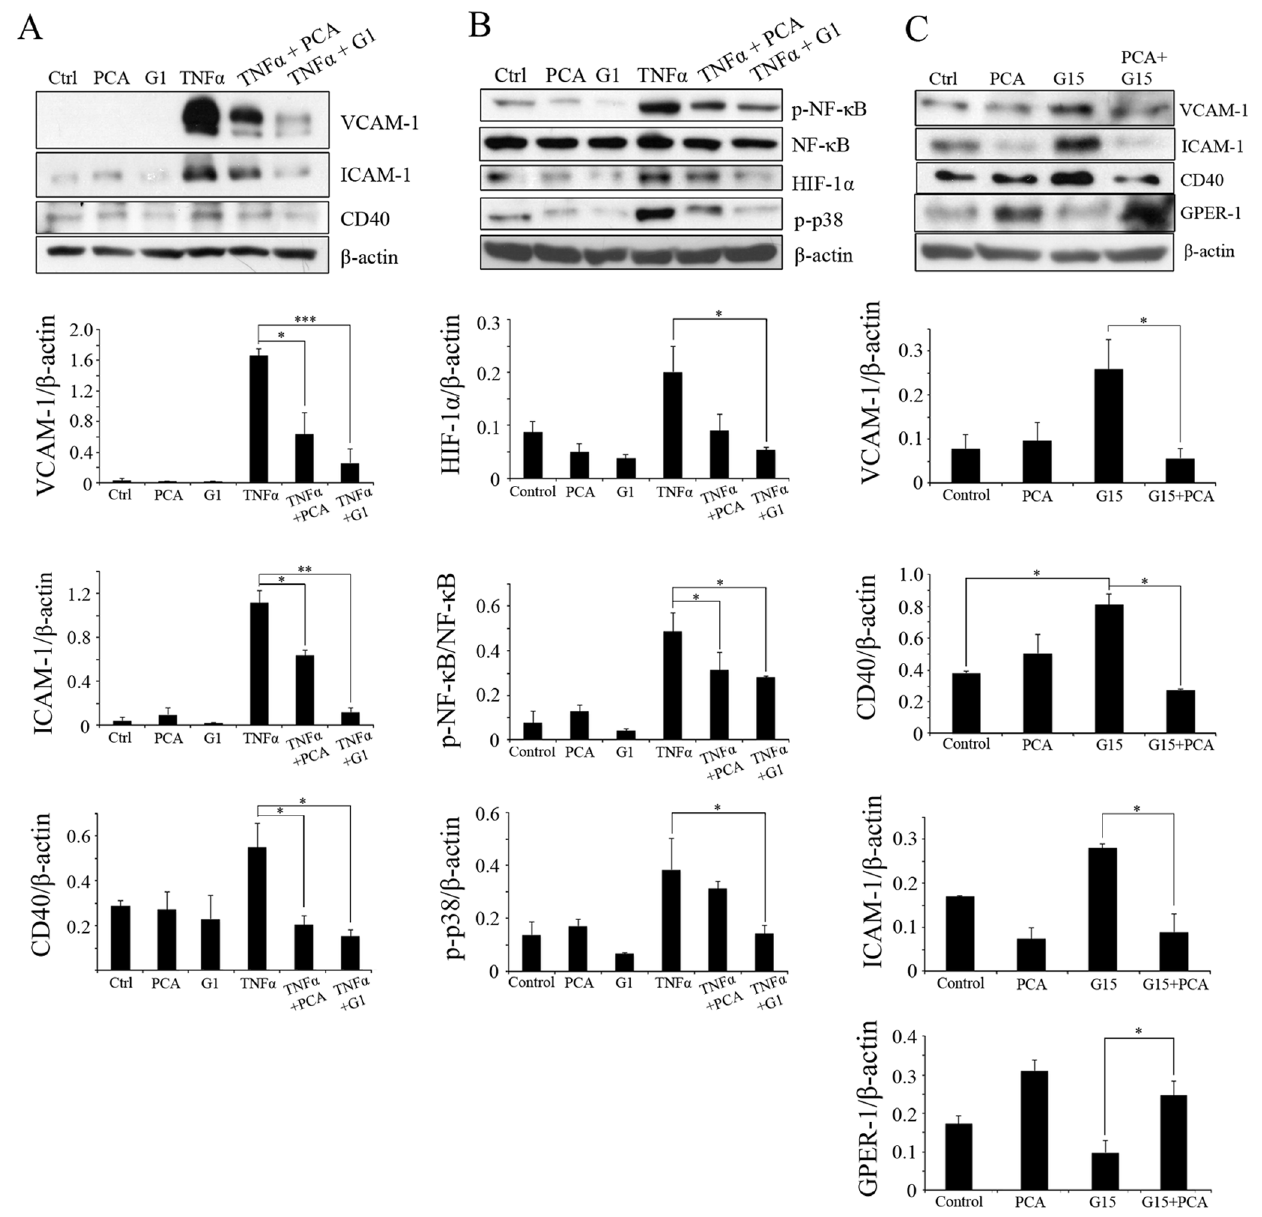
Figure 3. Human umbilical vein endothelial cells (HUVECs) treated with tumor necrosis factor alpha (TNF a ) and G15 induces inflammation. (A, B) HUVECs were pretreated with PCA (100 m M) and G1 (3.0 m M) for 24 hrs. (A) treatment with TNF a (10 ng/ml) for 6 hrs. (B) treatment with TNF a (10 ng/ml) for 1 hr. (C) HUVECs were pre-treated with PCA (100 m M) for 24 hrs and then treated with G15 (3.0 m M) for 6 hrs. Blots are representative of 3 independent experiments. (A, B, C) Densitometric analyses are presented as the relative ratio of ICAM-1, VCAM-1, CD40, HIF-1 a , GPER-1 or phospho-p38 to b -actin. (B) Densitometric analyses for phospho-NF- k B are presented as the relative ratio to NF- k B. Data are presented as mean 6 SEM; * P , 0.05, ** P , 0.005, *** P , 0.001.